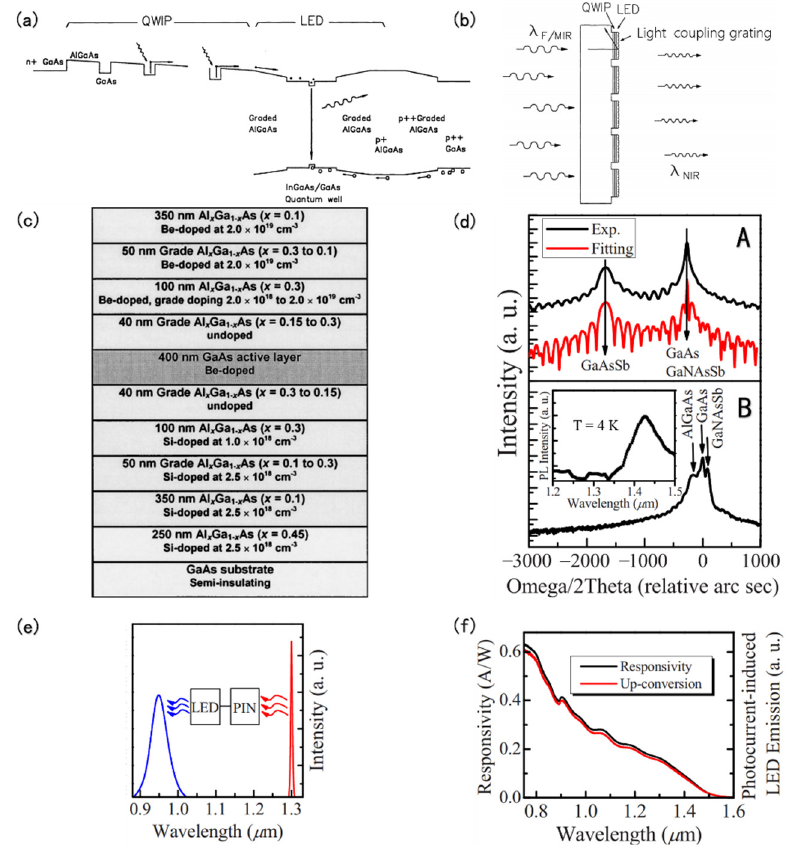
Figure 2. Structures and performance characterization of all-inorganic upconversion devices. ( a ) Bandedge profile of the proposed integrated quantum well intersubband photodetector (QWIP) and LED. ( b ) Schematic geometry of the proposed focal plane array of QWIP-LEDs [29]. Copyright 1955, Electronics Letters. ( c ) Schematic of experimental setup [31]. Copyright 2004, Journal of Ap- plied Physics. ( d ) Picture A shows the measured and fitted X-ray rocking curves for 100 nm thick GaAsSb/GaNAsSb two-layer structure on GaAs substrate. Picture B shows the measured X-ray rocking curve for GaNAsSb layer on GaAs substrate. The inset of picture B shows the PL spectrum of the GaNAsSb layer at 4K in a low-temperature environment. ( e ) Schematic of the test setup structures. The curves also present the intensity of absorbed light and emitted light. ( f ) PD’s responsivity under room temperature (black line) and the photocurrent-induced LED light emission of the upconversion device (red line) [32]. Copyright 2009, Applied Physics Letters.